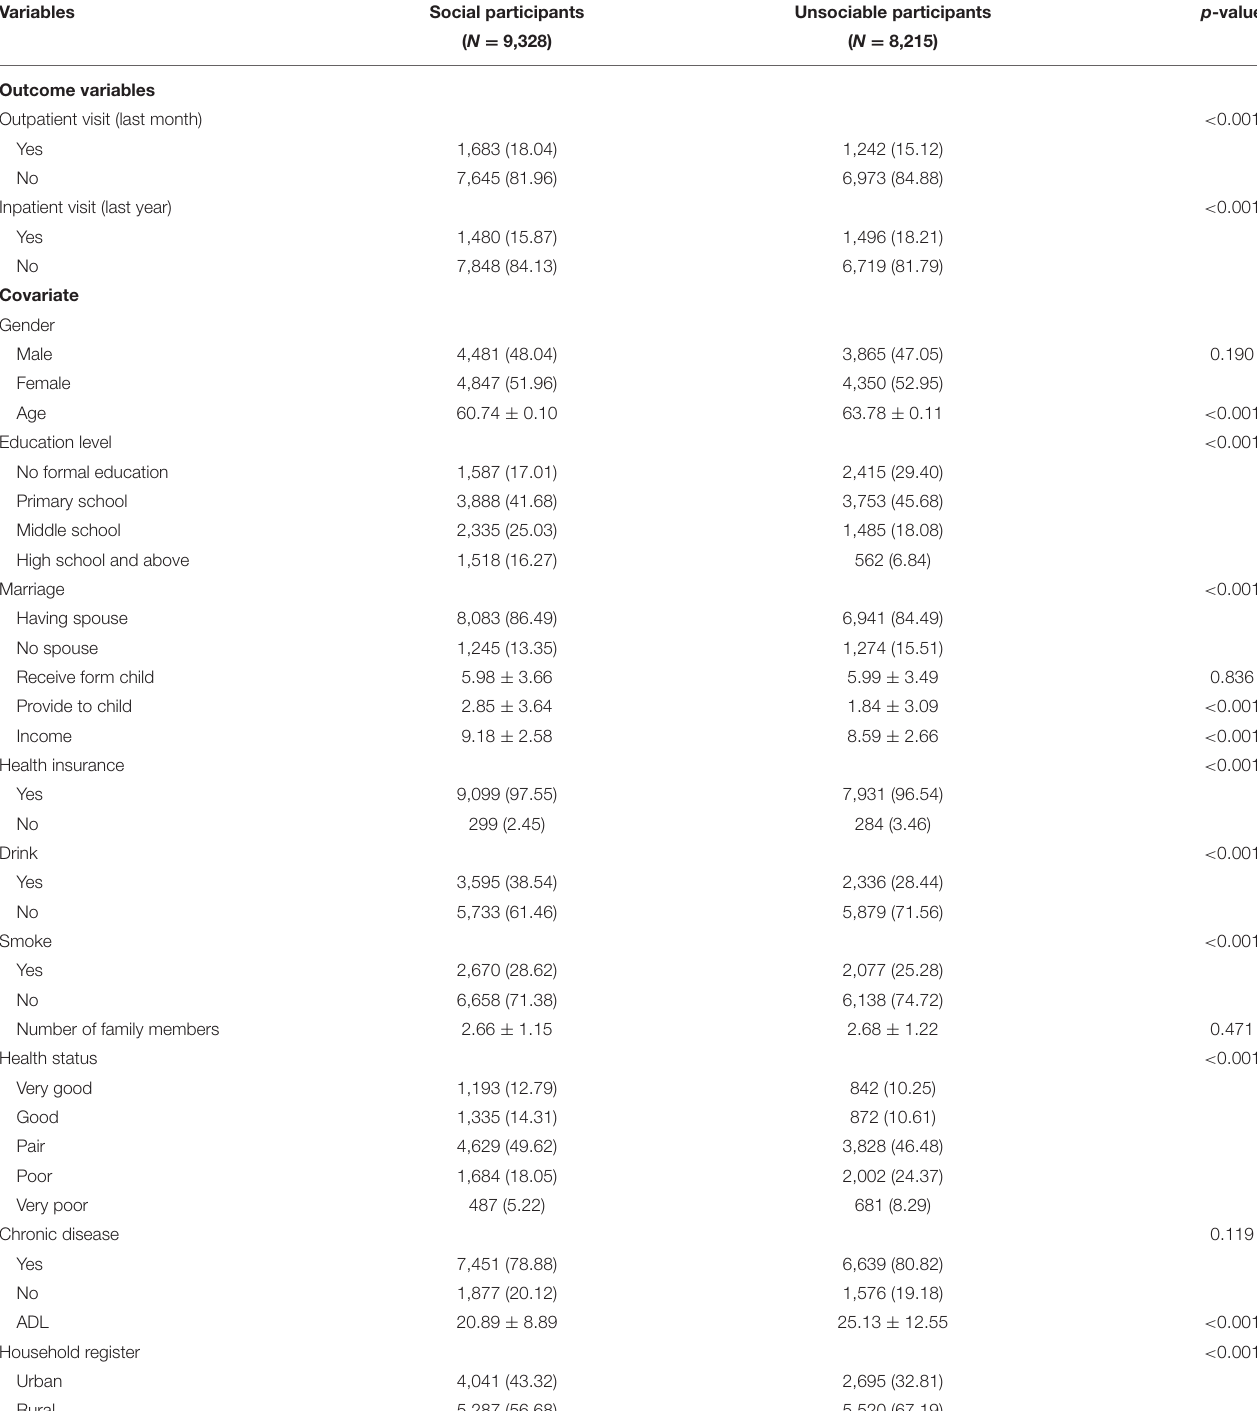
TABLE 1 | Characteristics of social and unsociable groups before